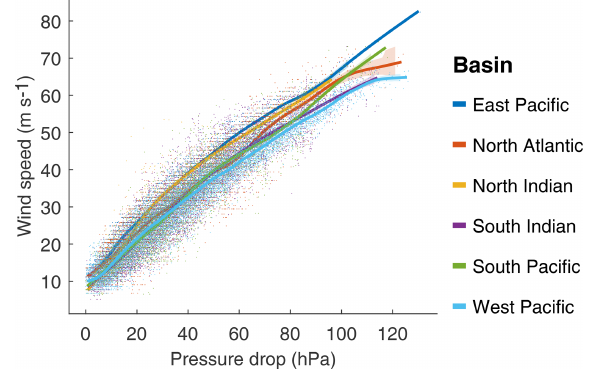
Figure 6. Maximum wind (ms − 1 ) and pressure drop (hPa) values from IBTrACS together with the fit of Eq. (3). The coefficients a and b fitted per basin are provided in Table